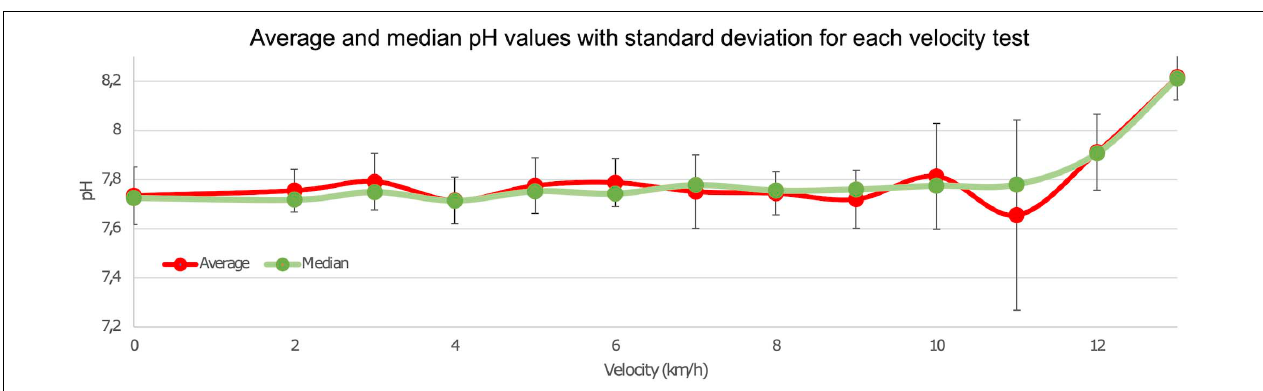
FIGURE 3 | Average, median, and standard deviation of all sensed raw pH measurement as a function of